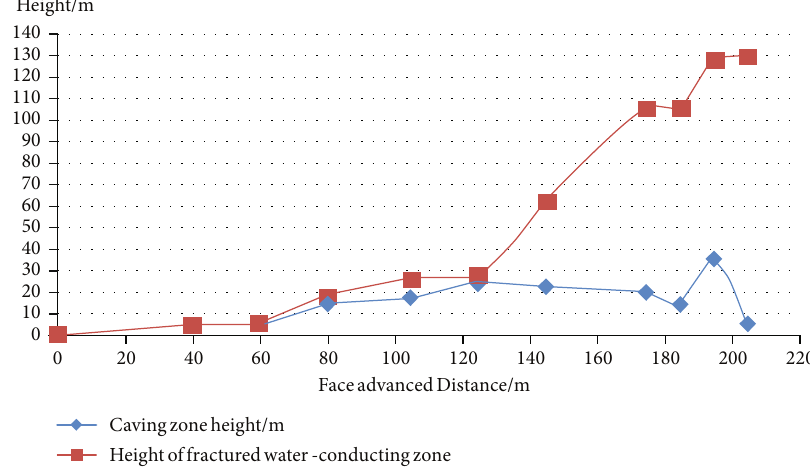
Figure 10: Curves of development height of water fl owing fractured zone with working face